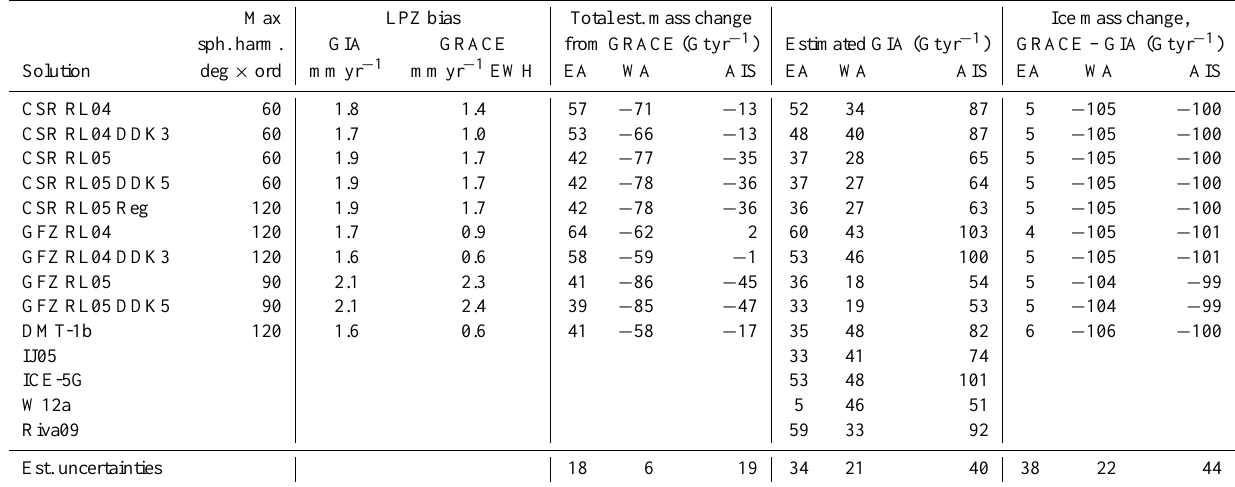
Table 2. Estimates of the mass change components derived from the data-driven approach. Uncertainties are 1- σ . Also provided is the maximum spherical harmonic degree and order of the original GRACE solution